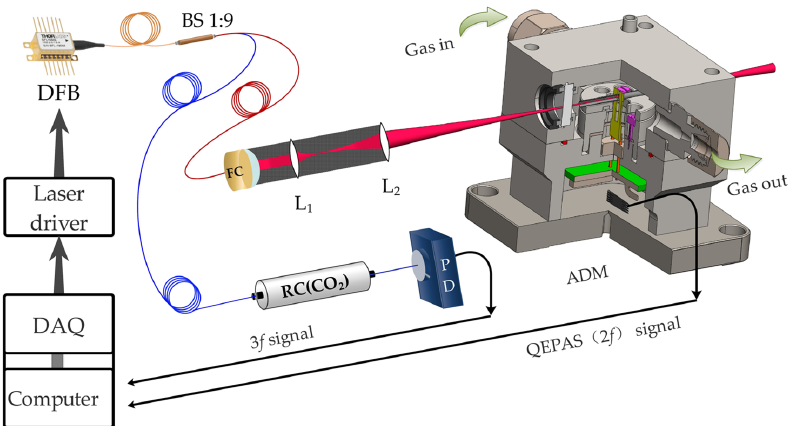
Figure 1. Line-locked quartz enhanced spectrophone. BS: beam splitter; FC: fiber collimator; L 1 and L 2 : mode-matching lens; RC: reference chamber; PD: photoelectric detector; DAQ: data acquisition card; ADM: acoustic detection module.